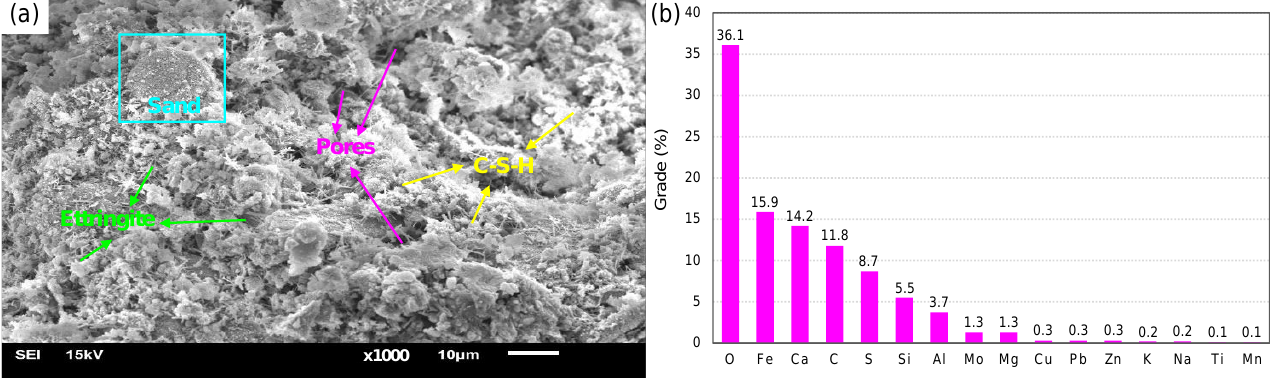
Figure 8. SEM ( a ) and EDS ( b ) results of 56-day cured CPB samples with 76 wt.% solid contents.